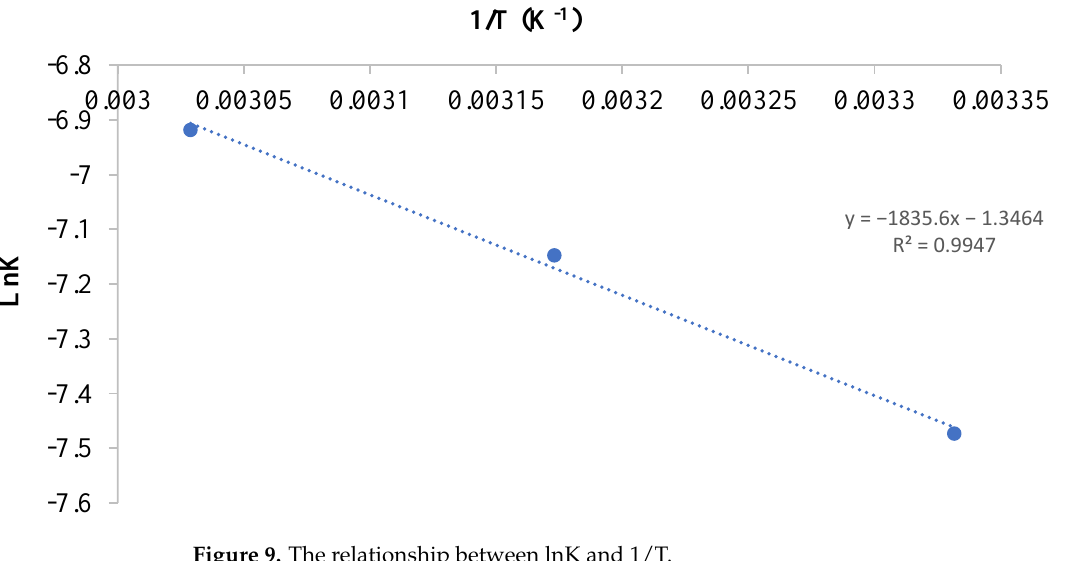
Figure 9. The relationship between lnK and 1/T.